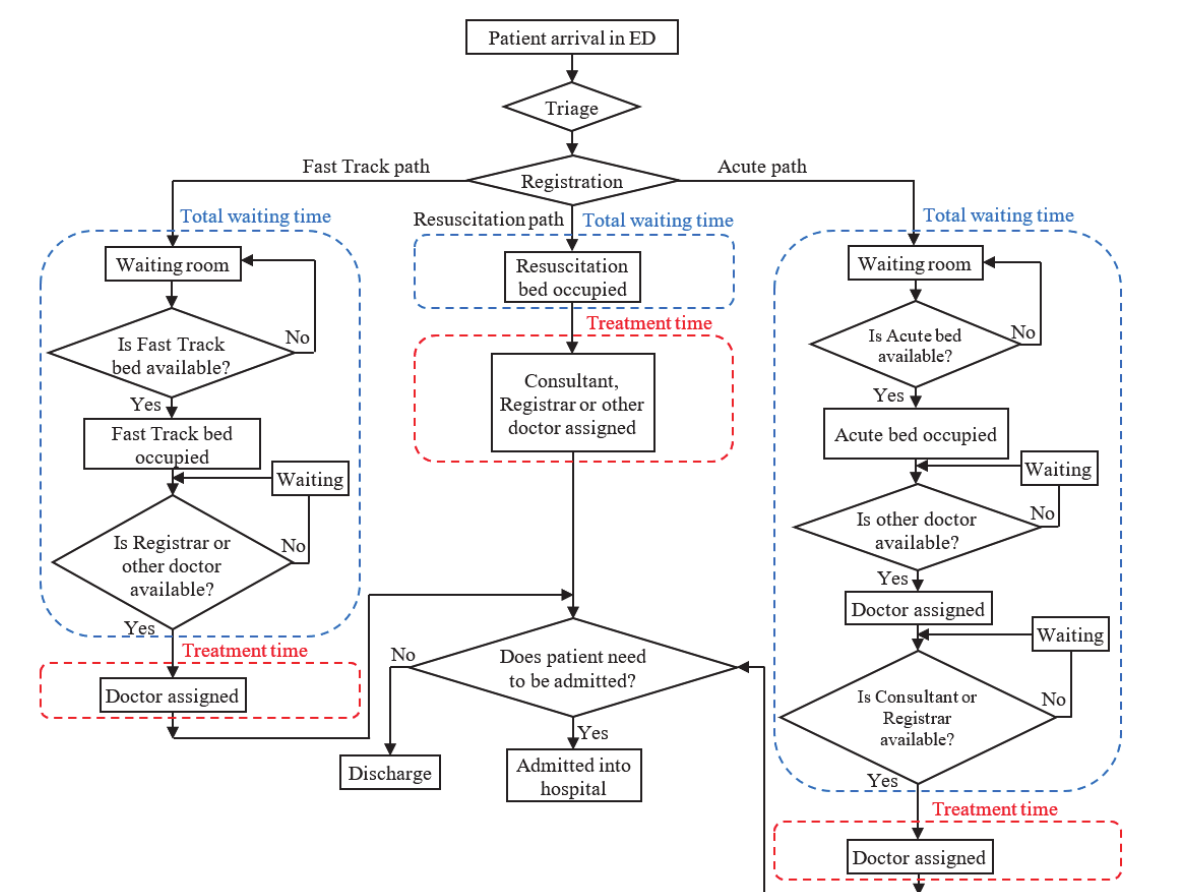
Fig. 2. Patient flow chart from a real ED